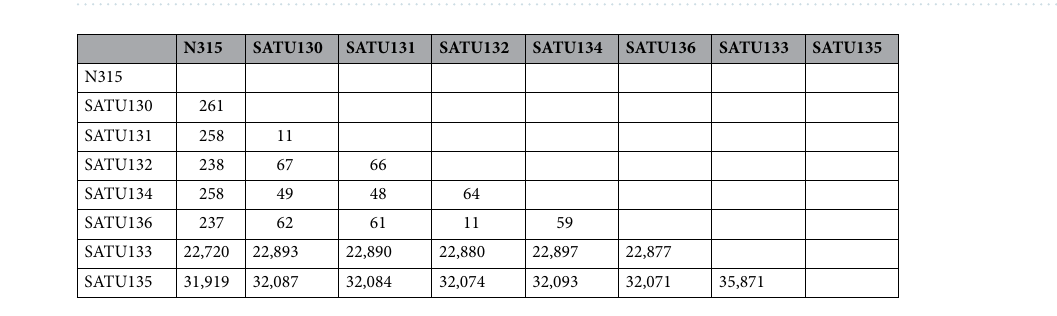
Figure 1. An ML phylogenetic tree of five ST764 isolates with N315 (ST5) as the outgroup. The deletions and insertions were labeled alongside with the branches shared by all isolates that shared the deletions/insertions as indicated with red (common to all isolates), blue and green. The HGVS nomenclature (available from http:// varno men. hgvs. org/) were used to describe the deletion and insertion events. The “unknown” indicated in the nomenclature means unknown inserted sequences.